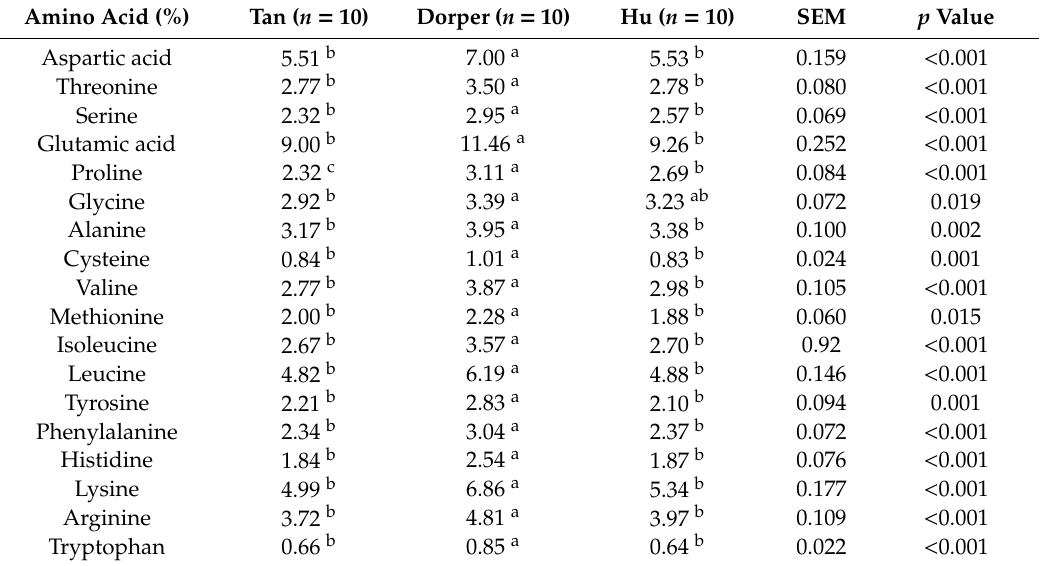
Table 6. E ff ect of breed on amino acid (%) of